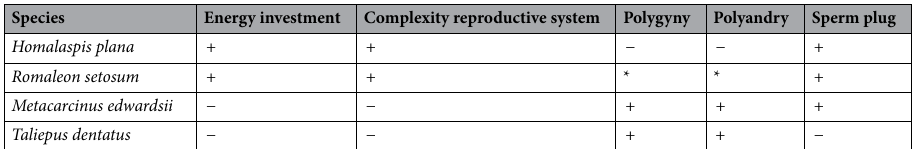
Table 3. Summary of energy investment in the four brachyuran species studied. The complexity of the reproductive system, intensity of mating, polyandry (based on observations in the laboratory) and existence of a strategy to prevent competition (i.e. sperm plug) are indicated for each species and may play key roles in energy investment. *Refers to not investigated yet.